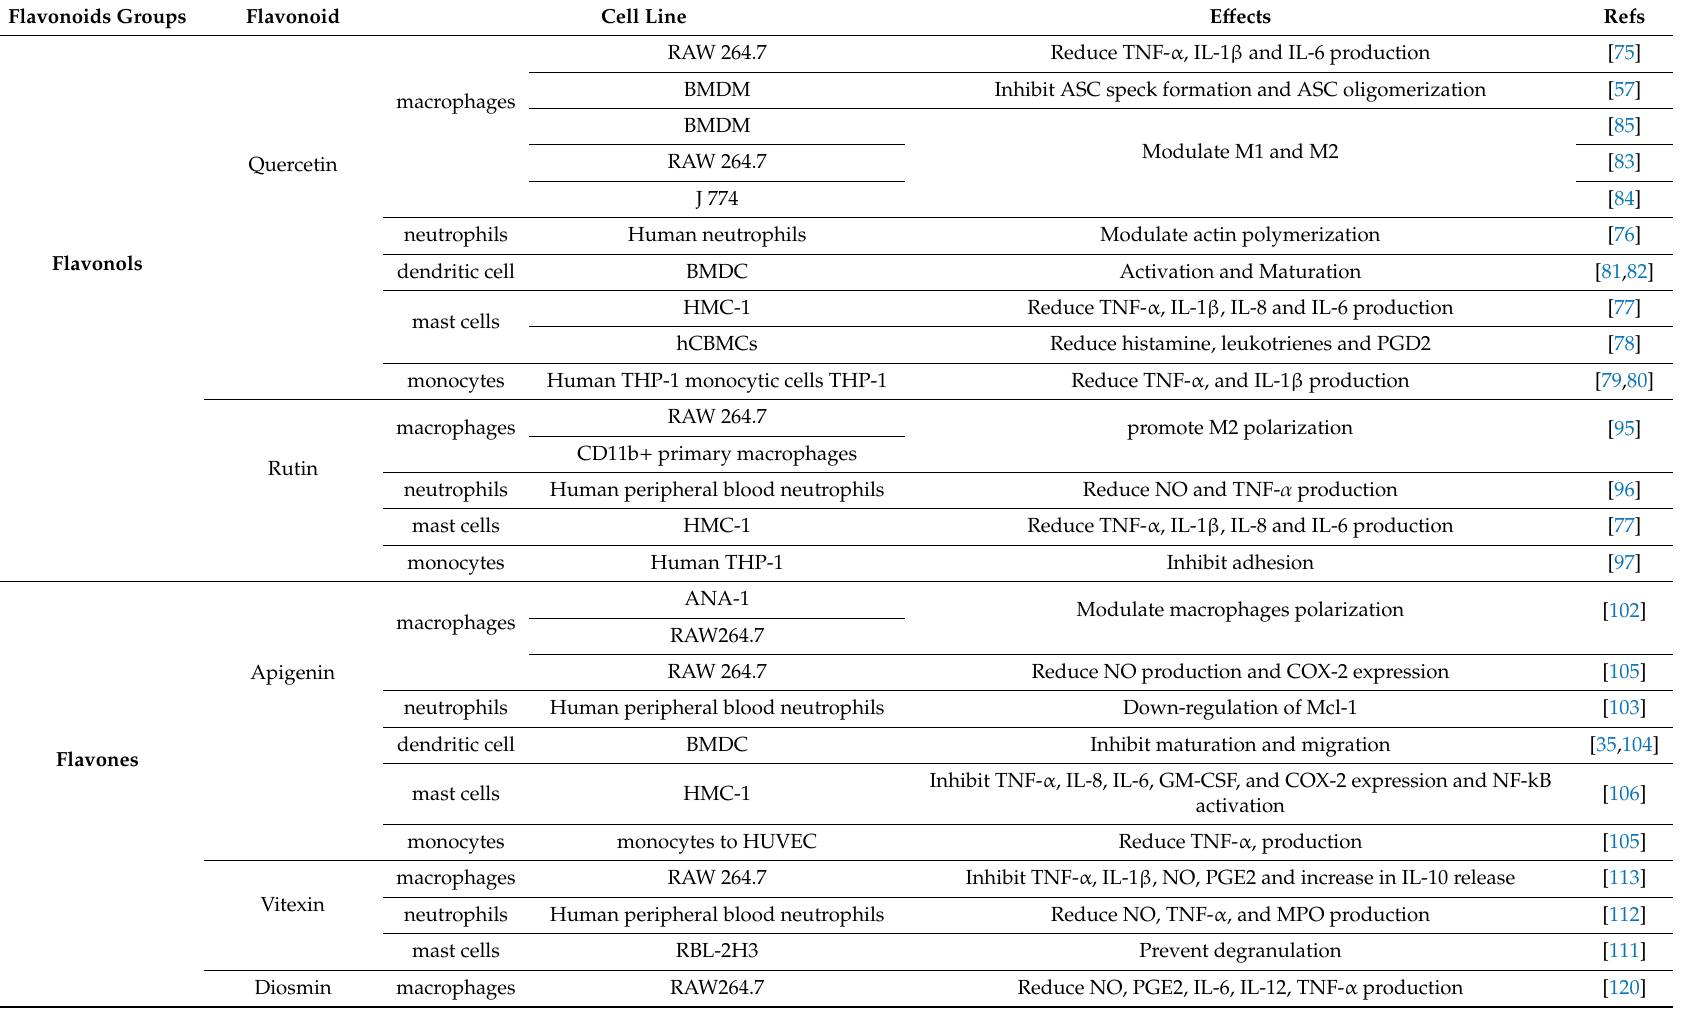
Table 1. Pre-clinical studies analyzing the e ff ects of di ff erent flavonoids on cell